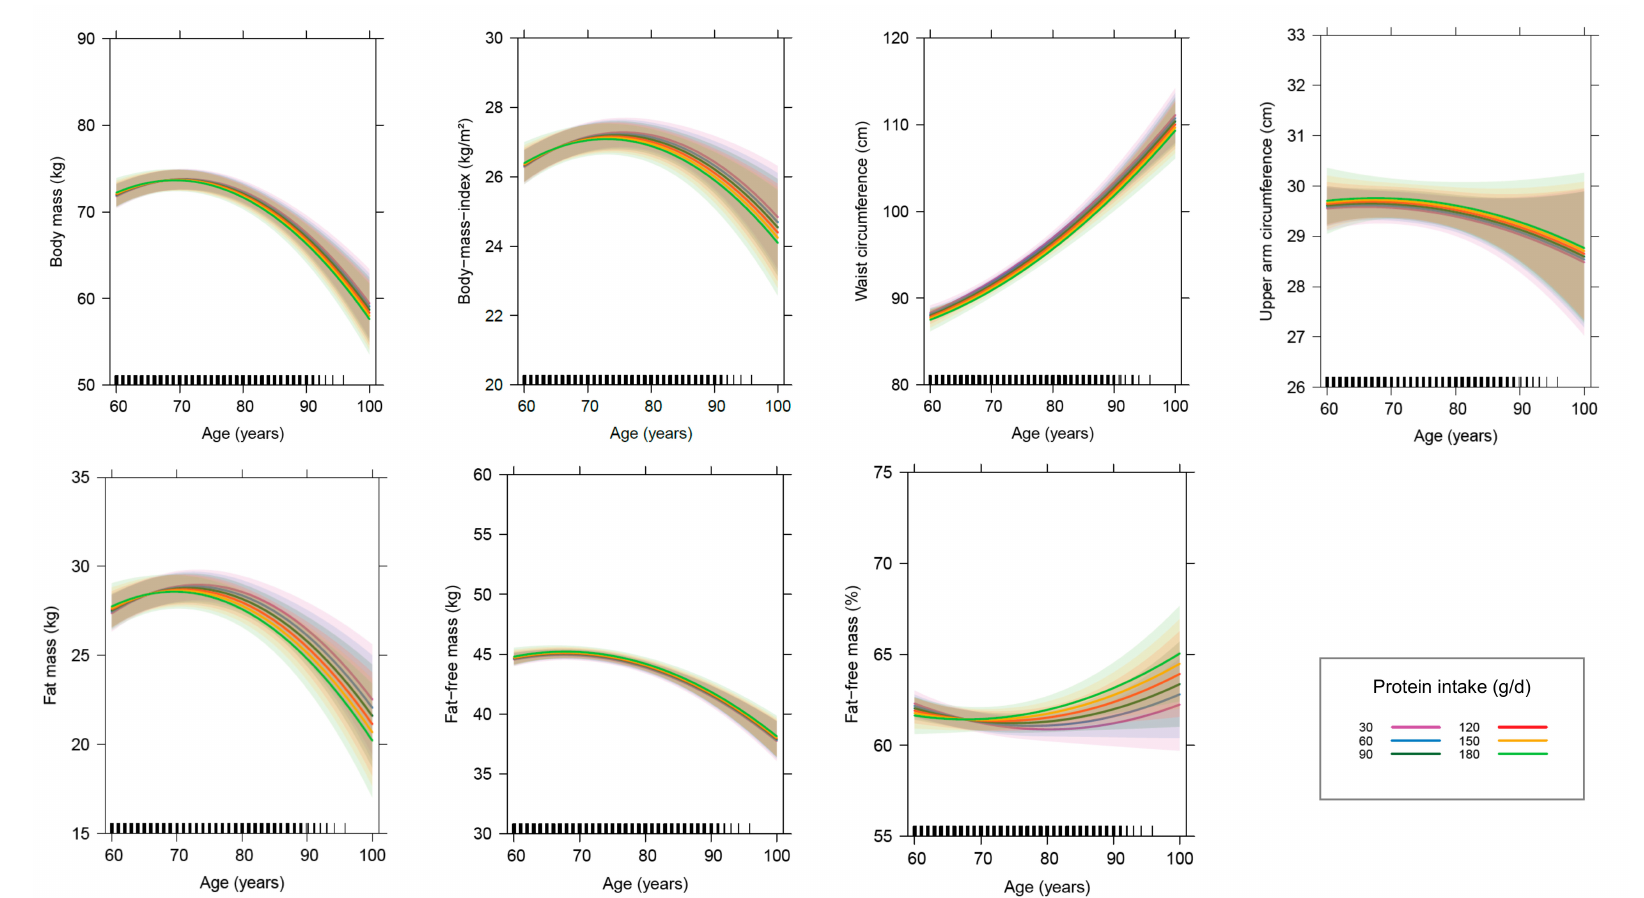
Figure 4. Age-related changes in parameters of anthropometry and body composition in dependence of the daily protein intake. This figure displays the e ff ect of age on parameters of anthropometry and body composition in dependence of the daily protein intake after controlling for other variables in the linear mixed-e ff ects models ( n = 401). The colored lines show the age-related changes in parameters of anthropometry and body composition at di ff erent dietary protein intake levels, ranging from 30 to 180 g / day. The thick lines represent the estimated means and the respective colored areas reflect the 95% confidence intervals. The small black pillars on the x -axis reflect the numbers of records at the respective age of the